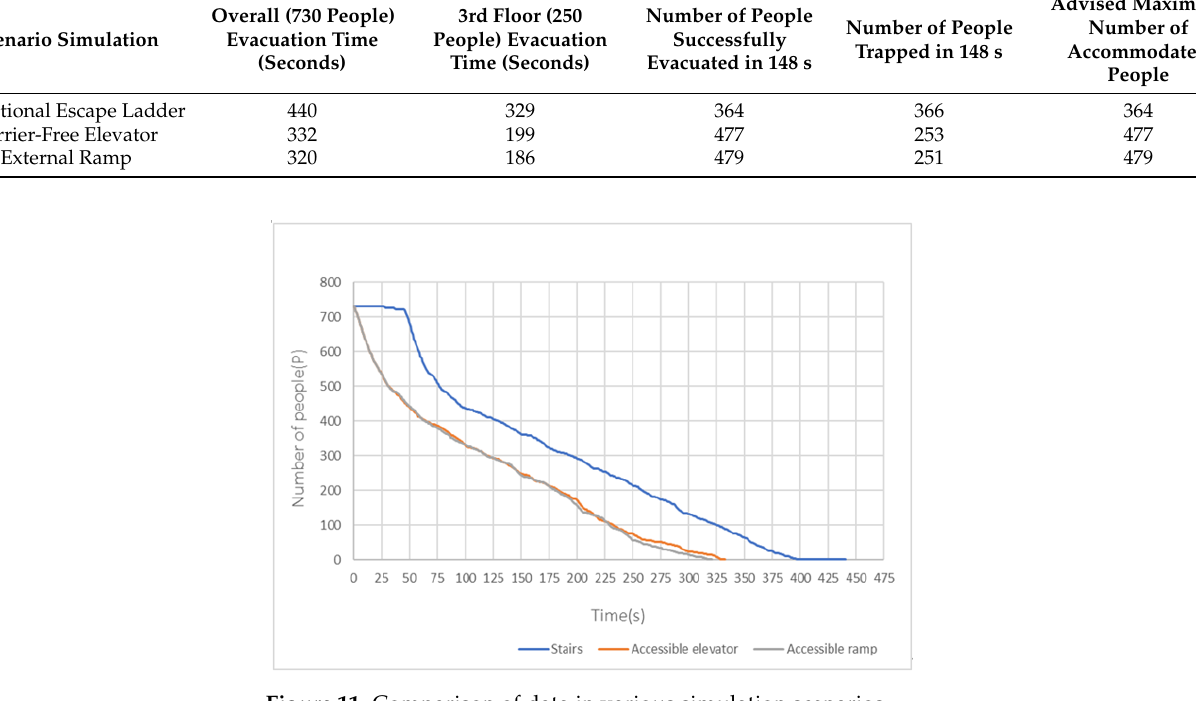
Figure 11. Comparison of data in various simulation scenarios.